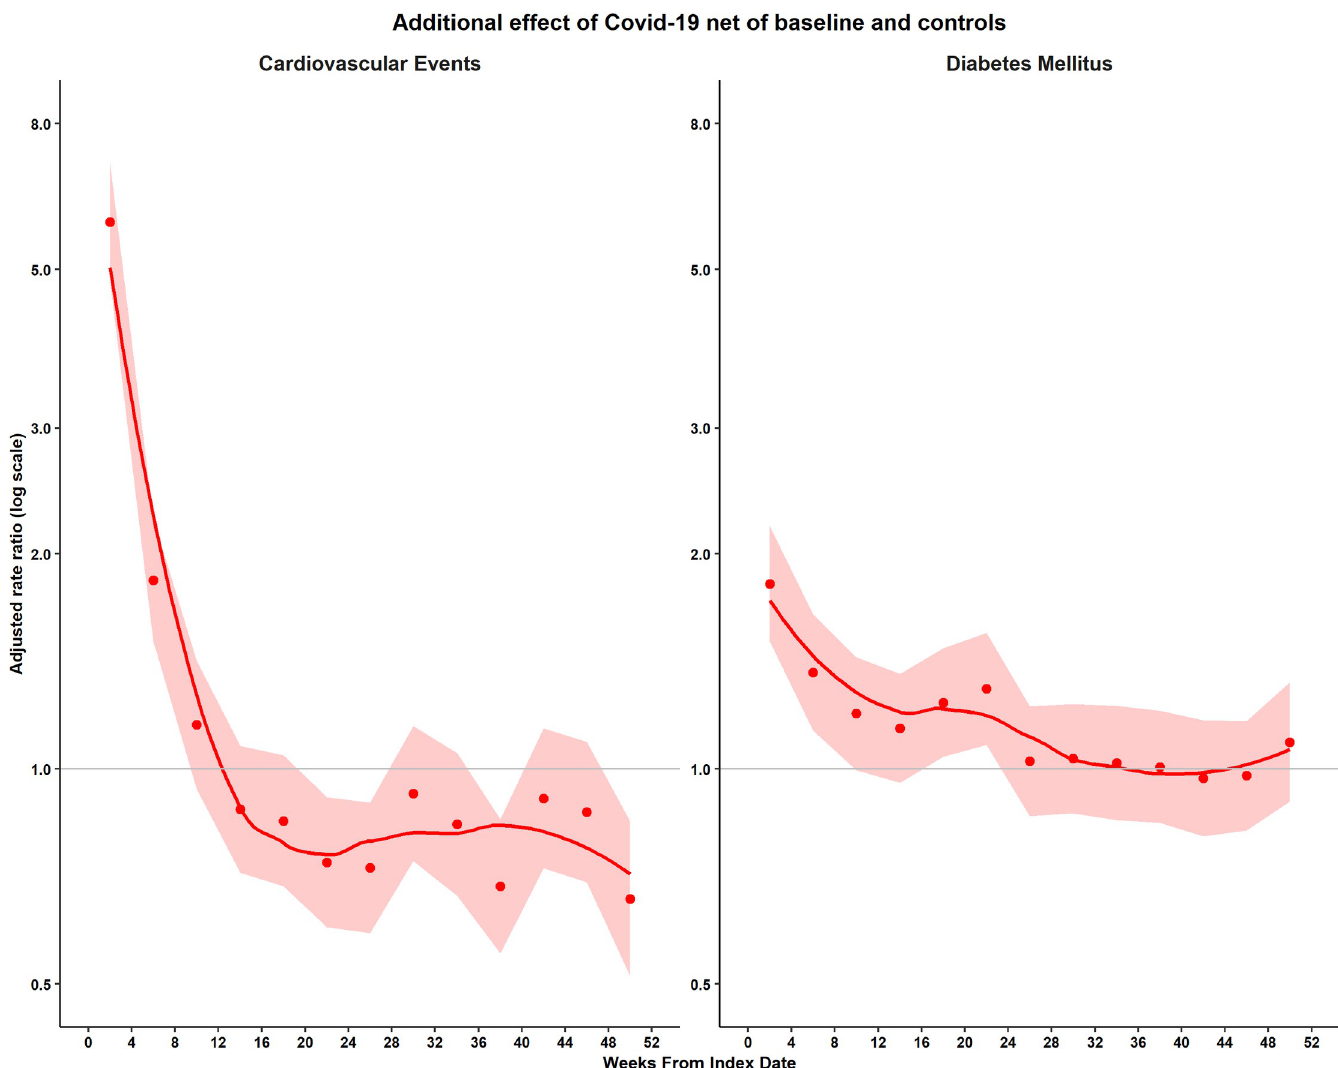
Fig 3. Adjusted rate ratios by 4-week period following COVID-19. Points represent adjusted rate ratios, bands represent 95% CIs, line represents smoothed curve. (Estimates were adjusted for age, ethnicity, smoking, BMI category, SBP category, Charlson score, index month, and matched set.) BMI, body mass index; CI, confidence interval; COVID-19, Coronavirus Disease 2019; SBP, systolic blood